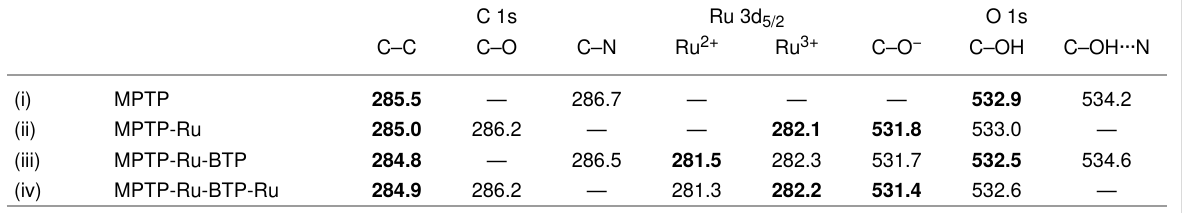
Table 1: Binding energies (in eV) of C 1s, Ru 3d 5/2 , and O 1s core levels given for the consecutive wire growth steps shown in Figure 1. a